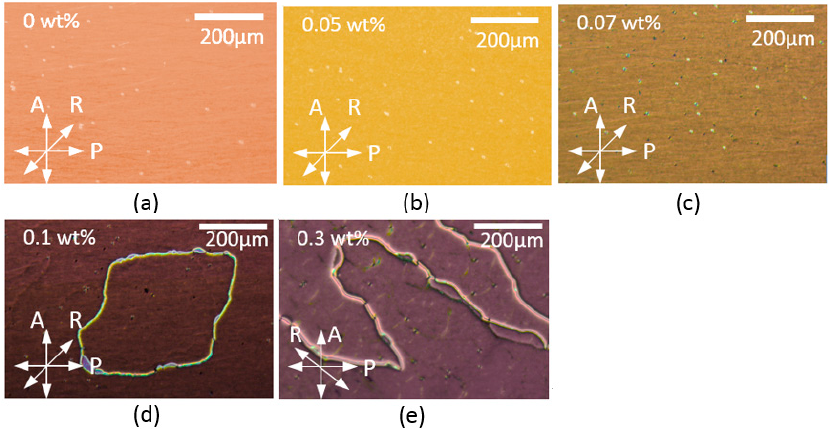
Figure 1. POM photographs of LC cells doped with GNP concentrations of ( a ) 0 wt %, ( b ) 0.05 wt %, ( c ) 0.07 wt %, ( d ) 0.1 wt %, and ( e ) 0.3 wt %.